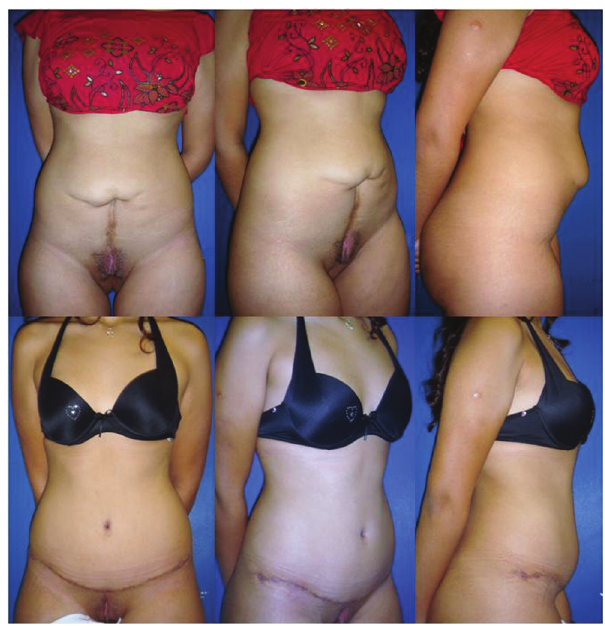
Figure 2 - Above – pre operative. Below – post operative